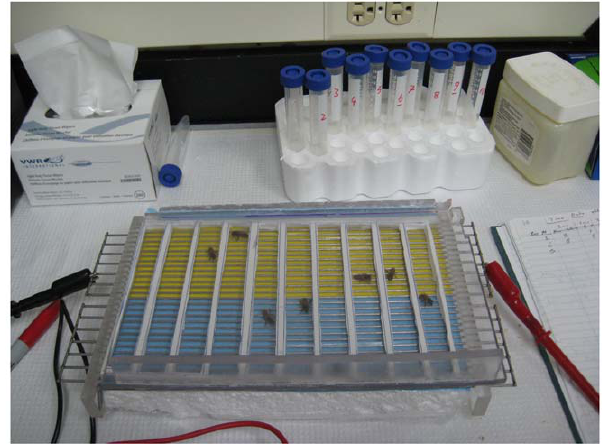
Figure 1. Place preference assay apparatus. Bees are placed in individual lanes, sandwiched between a Plexiglas H cover and a metal grid that is electrified (6 V, 50 mA) on one half. The halves have a color card placed under the grid. In this picture the yellow half is electrified and blue half is ‘‘safe’’. Bees develop preference for the safe half, they show avoidance to the color side associated with electric shock. To prevent bees from walking upside-down and avoiding the shock, the Plexiglas H cover is coated with a thin layer of Vaseline, using a wipe. Bees are transported in 15 ml numbered culture vials and followed individually. Both manual records of position at every 15 secs and video recording and transcription are used for data collection.